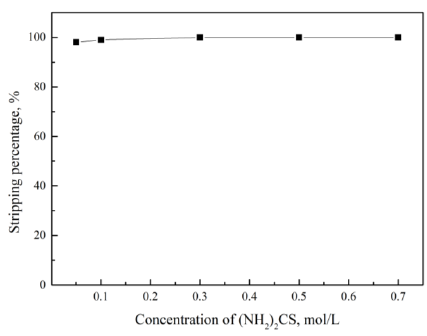
Figure 6. Effect of thiourea concentration on stripping of Pd(II).